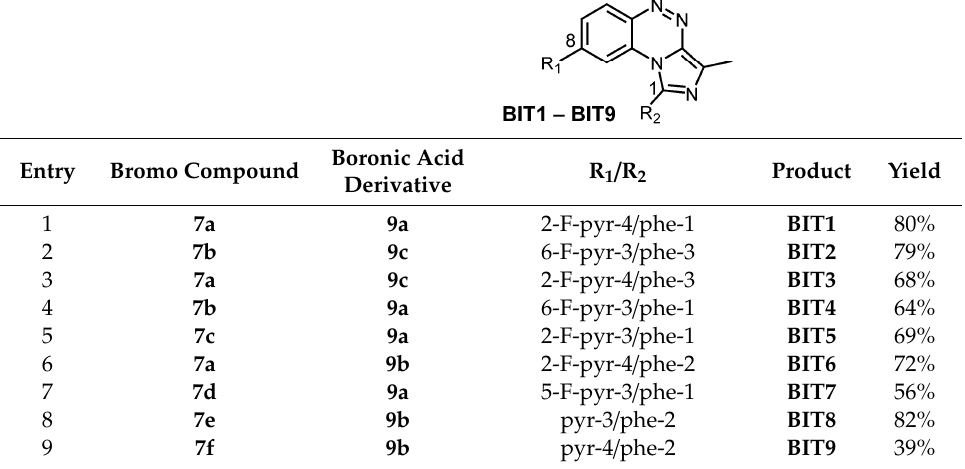
Table 2. Series of BIT derivatives according to Scheme 2.